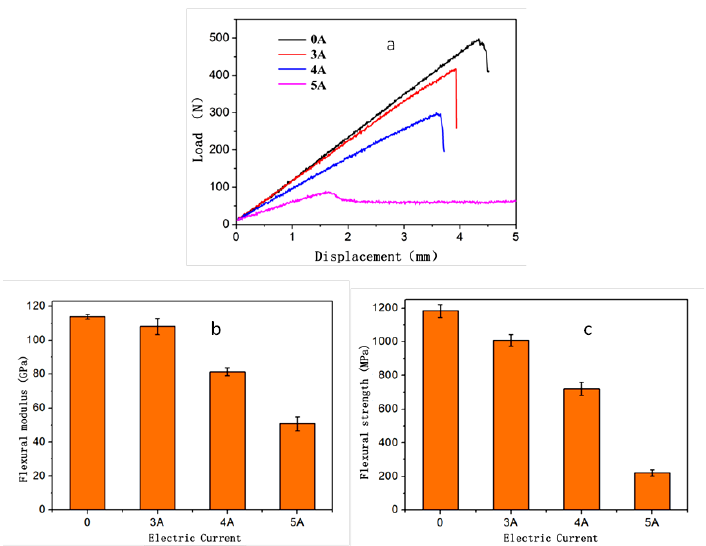
Figure 4. The three-point bending results of the CF/EP composites under the loading of different electric currents from 0 to 5 A. ( a ) Representative force-displacement curves; ( b ) flexural modulus; and ( c ) flexural strength.